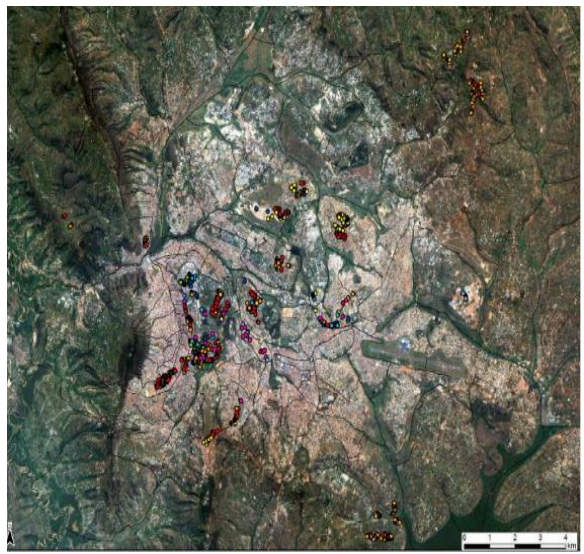
Figure 1: Overview on the city of Kigali. The illustrate the spatial distribution of the collected reference data (1,053 samples).